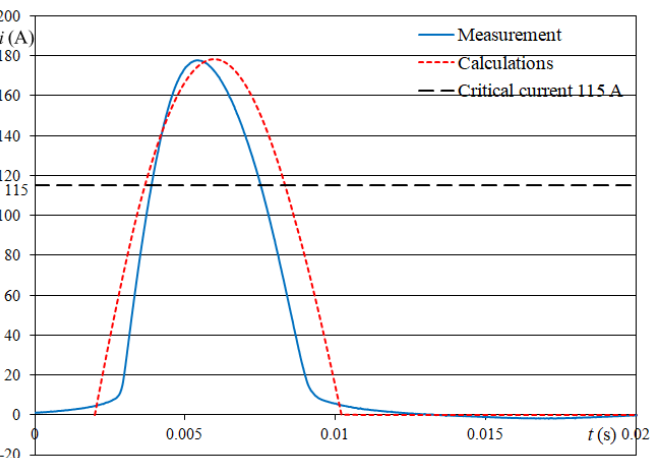
Figure 14. First impulse of the inrush current of the 8.5 kVA HTS transformer, measured and calculated.